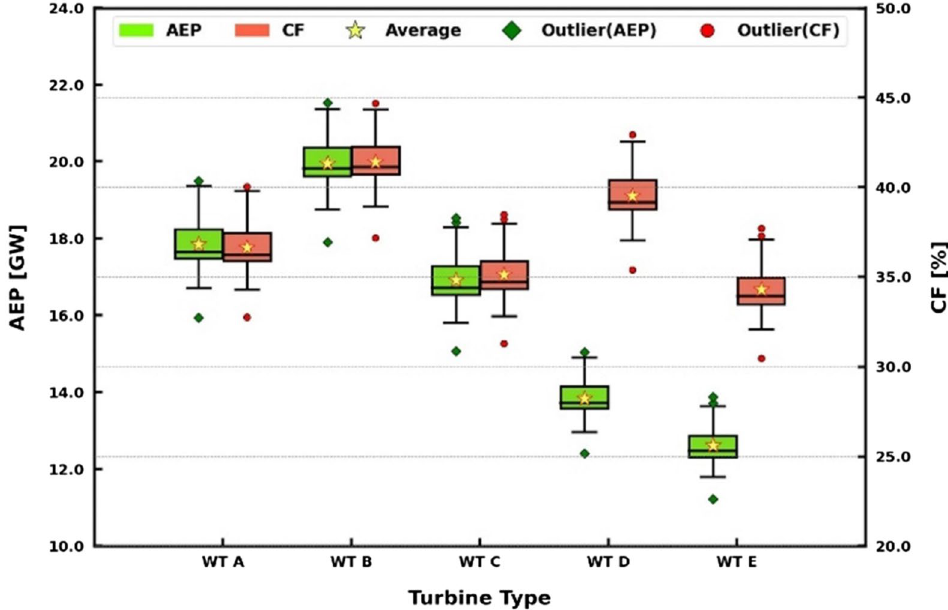
Figure 12. Box plot of the 30-year AEP and the CF estimates by the selected wind